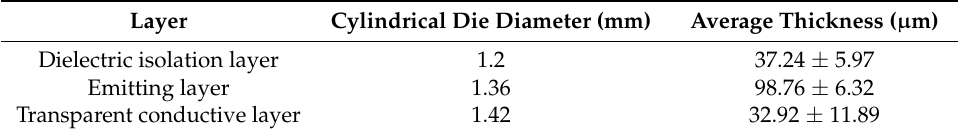
Figure 4. Effect of increasing fiber diameter on fiber bending radius. Table 1. Average layer thickness produced by final cylindrical slot die design